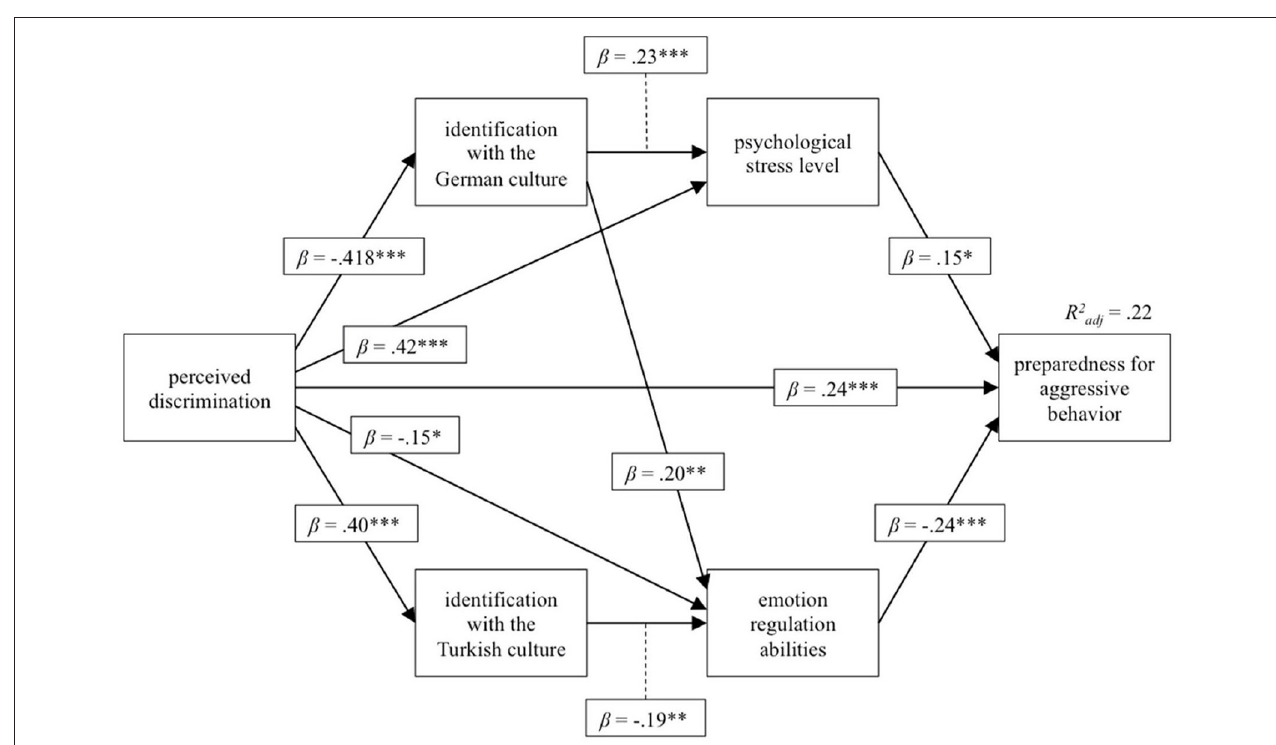
FIGURE 1 | Path model for the relation between perceived discrimination, identification with the Turkish or German culture, the psychological stress level, emotion regulation abilities and the preparedness for aggressive behavior. * P < 0.05, ** p < 0.01, *** p < 0.001; R 2 , explained variance; β s , standardized beta coefficient.